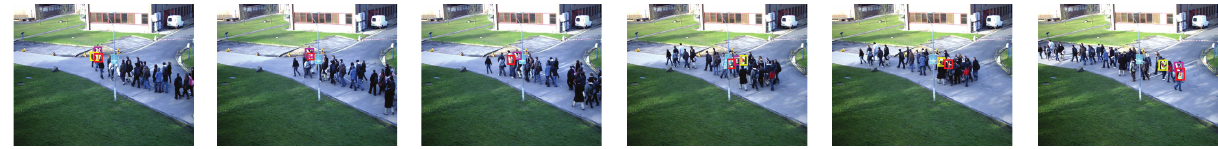
Figure 6: The typical results of Multiple flow view1 (Frame: 12, 17, 24, 48, 55, and